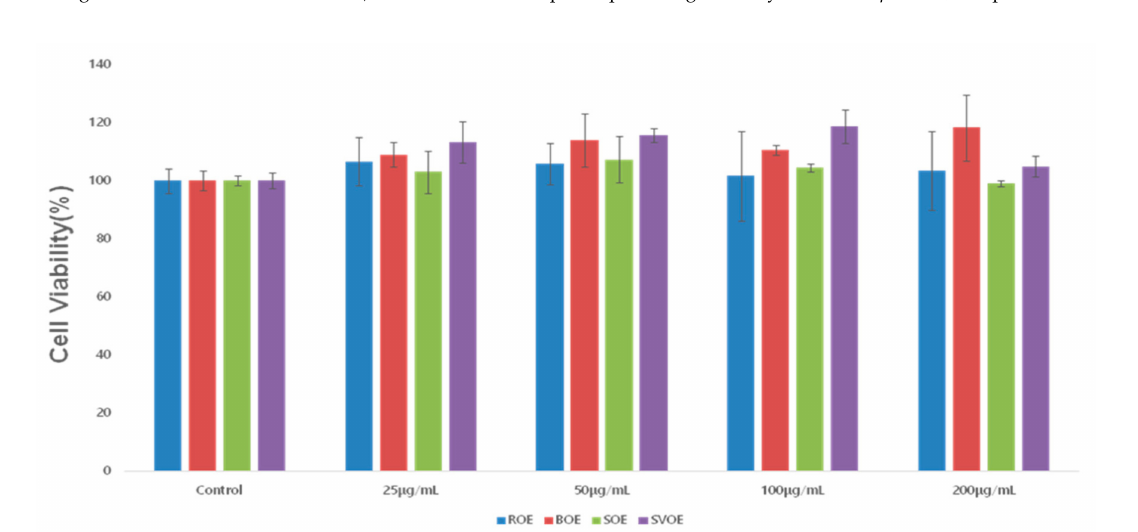
Figure 1. Effect of cooking methods and okra extract on cell viability in LPS-induced RAW264.7 cells. Cells were treated with ROE, BOE, SOE, and SVOE (25, 50, 100, 200 µ g/mL), then with or without LPS (1 µ g/mL) for 24 h. The cell proliferation was estimated by an MTT assay. Each bar represents the mean ± SD. LPS: lipopolysaccharide. ROE: raw okra ethanol